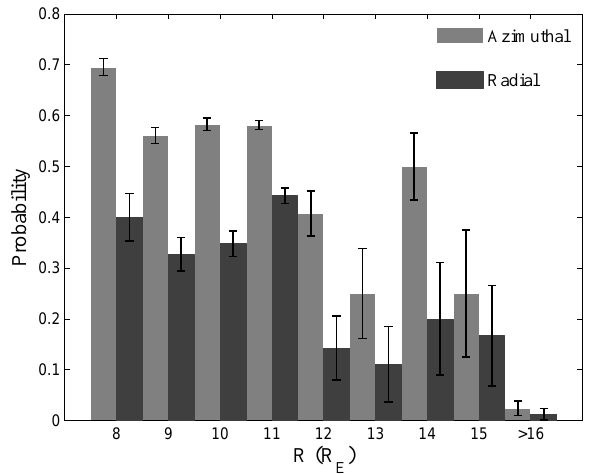
Figure 7. The radial distribution of the probability of identifying standing waves for azimuthal and radial oscillating events (light and dark histograms,